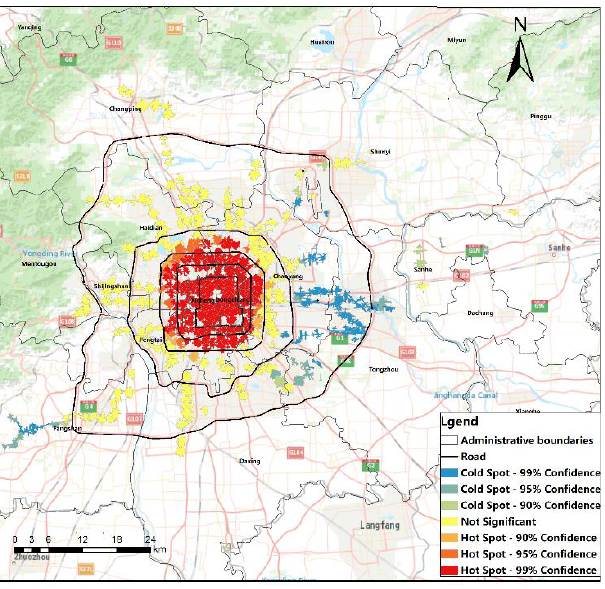
Figure 4. Hotspot analysis of Beijing rail transit station area accessibility.